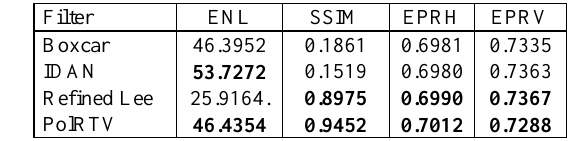
Table 1. Quantitative evaluation of the filtering performance